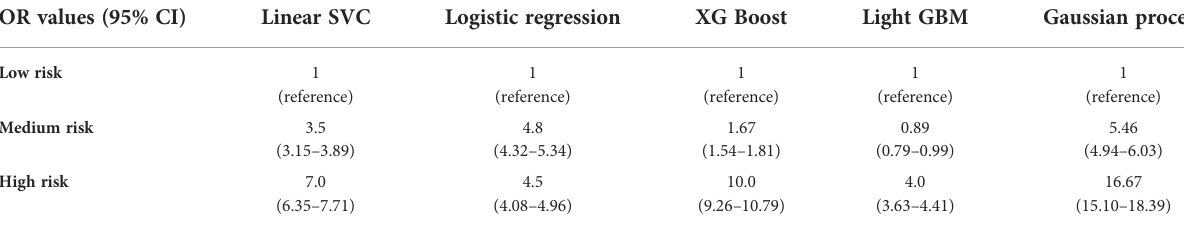
TABLE 4 Odds ratio and con fi dence intervals between different risk group in fi ve machine learning classi fi ers. OR values (95%